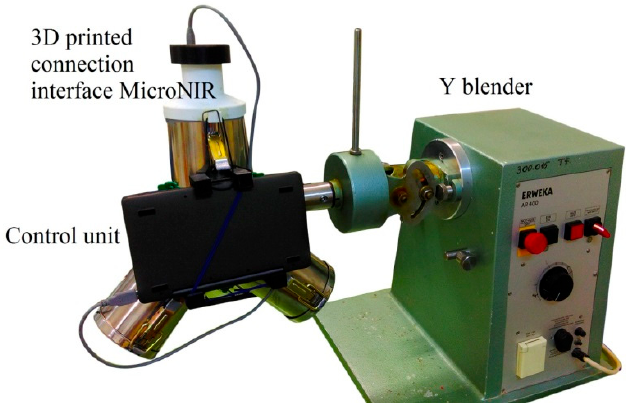
Figure 5. Experimental setup for in ‐ line monitoring of the blending